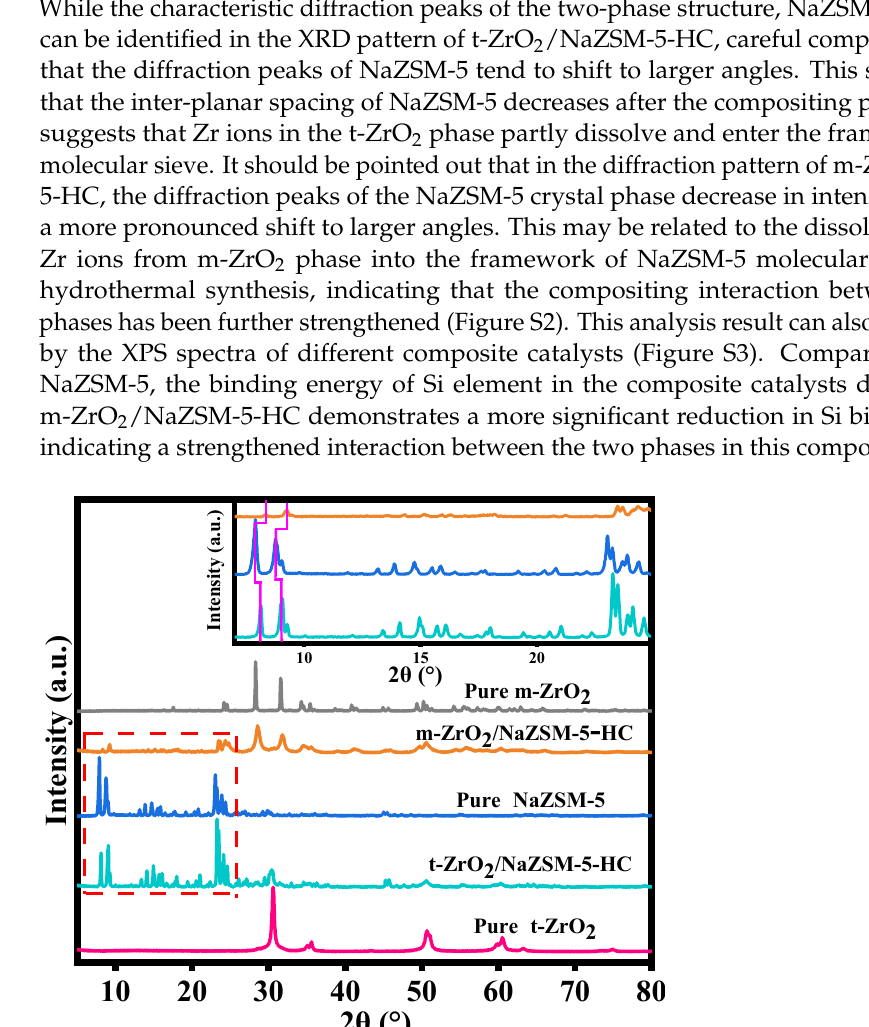
5 of 13 Figure 1. Catalytic performance of m-ZrO 2 /NaZSM-5-HC and t-ZrO 2 /NaZSM-5-HC composite cat- alysts: ( a ) methanol conversion rate and ( b ) selectivity to CH 3 SH.